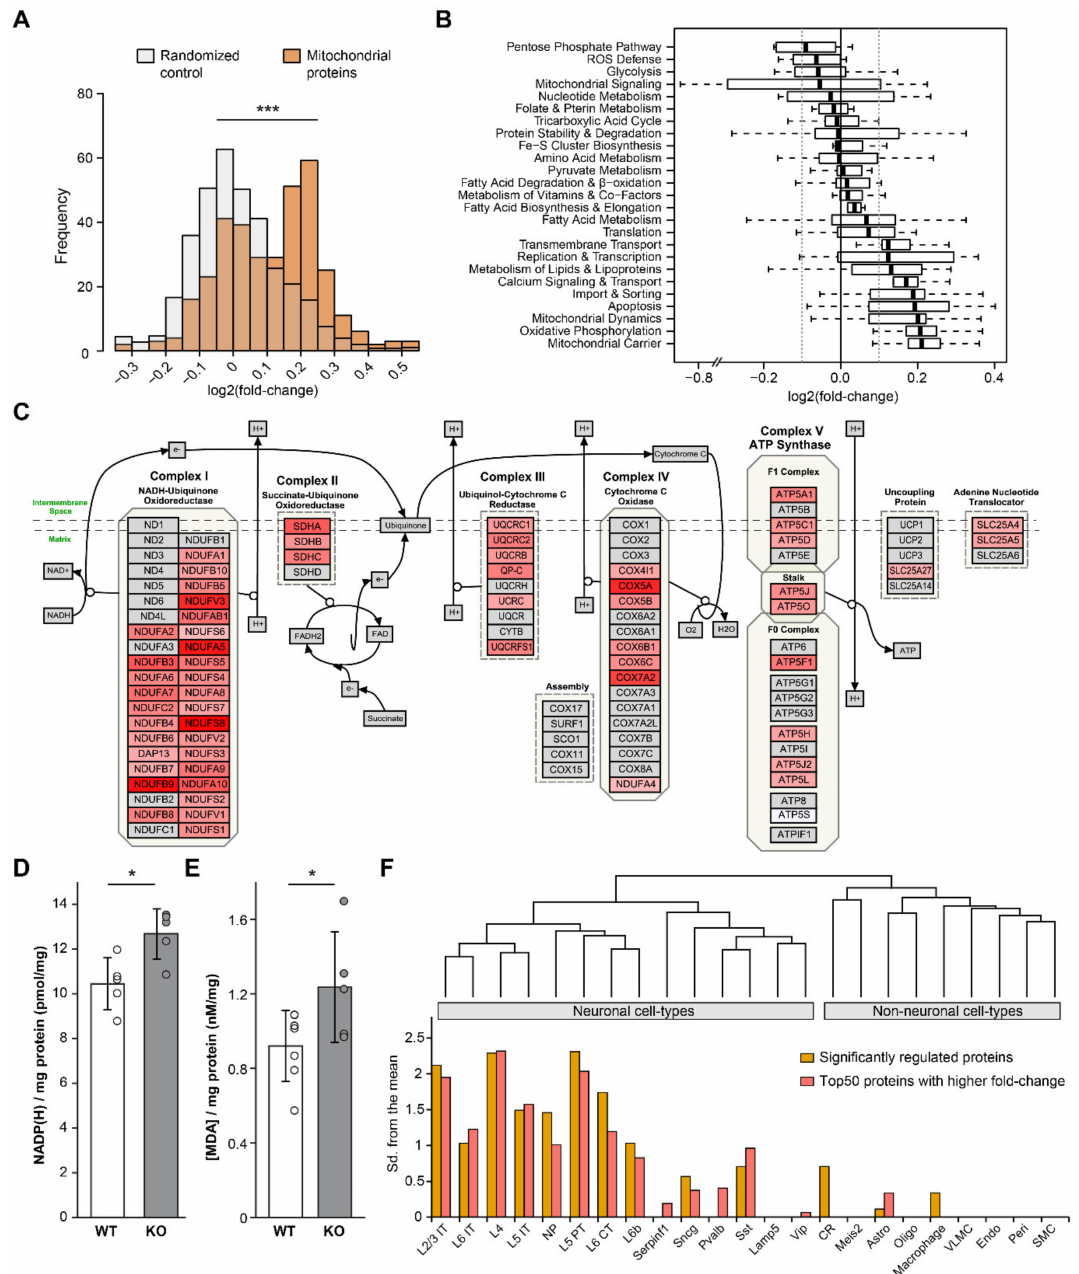
Figure 4. Mitochondrial pathway and cell-type enrichment analysis of CTEP-induced protein expression regulation. ( A ) Distribution of protein expression fold-changes induced by the treatment with CTEP (CTEP2h group) for all quantified mitochondrial proteins and a randomized control (100 iterations). The mitochondrial proteins distribution was significantly different from the control. ( B ) Boxplot showing the distribution of mitochondrial protein expression fold-changes (CTEP2h group) in different functional categories based on MitoXplorer. Solid and dotted vertical lines indicate no change and ± 0.1 fold-change (log2), respectively. ( C ) Visualization of CTEP-mediated protein expression modulation onto the mitochondrial electron transport chain (wikipathways WP111_107324). Color gradient represents the protein expression fold-change (CTEP2h group). Proteins in gray were not identified. ( D ) Total level of the cofactor NADP/H was increased in mGluR5 KO hippocampus compared to WT (N = 5). ( E ) Total MDA (malonaldehyde) level was increased in mGluR5 KO hippocampus compared to WT (N = 7 for WT; N = 5 for KO), as an assessment for oxidative damage. ( F ) Expression weighted cell-type enrichment analysis for the differentially abundant mitochondrial proteins and the 50 mitochondrial proteins with larger fold-changes upon CTEP2h treatment. The dendogram represents the hierarchical relationship between cell-types. * p < 0.05, *** p < 0.001. All bar graphs, means ±